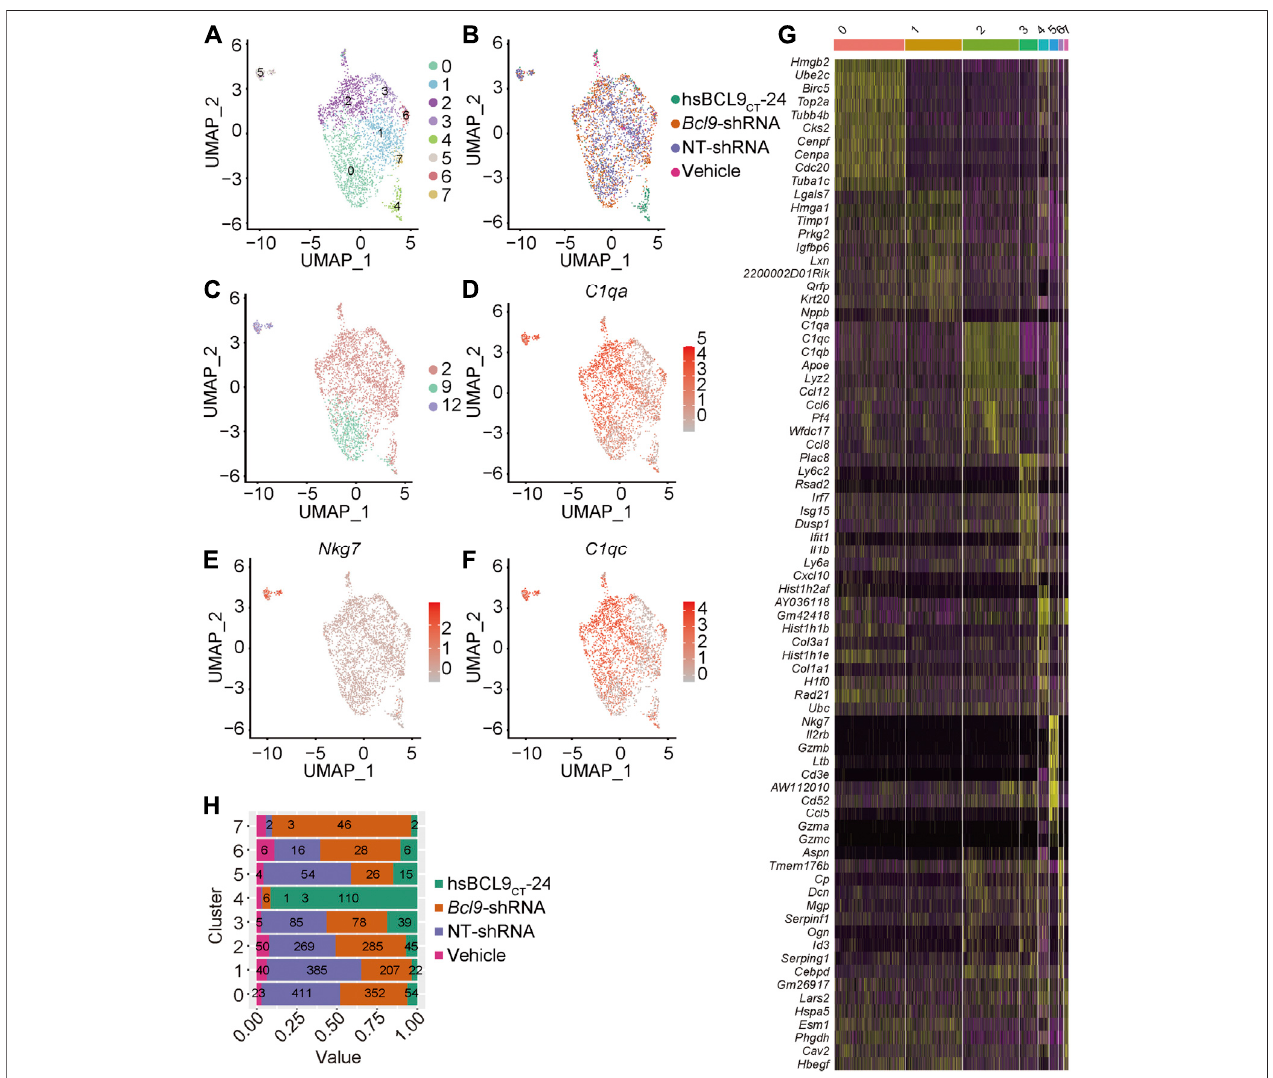
FIGURE6| Re-cluster (Step 2re-clustering) analysisofTAM(monocytes) and delineated NK-likenon-functioningcell. (A) UMAP mappingand clusters. (B) UMAP mapping and groups (vehicle, hsBCL9 CT -24, NT-shRNA, Bcl9 -shRNA). (C) UMAP mapping and Step 1 re-clustering clusters labeling. (D – F) UMAP mapping and monocytes and NK cell marker gene expression level (C1qa, C1qc and Nkg7). (G) Barchart of cell proportions of different groups in Step 2 re-clustering, the number is the actual number of cells. (H) Heatmap of the 7 clusters from Step 2 re-clustering. Columns, individual cells; rows, genes (Top10).